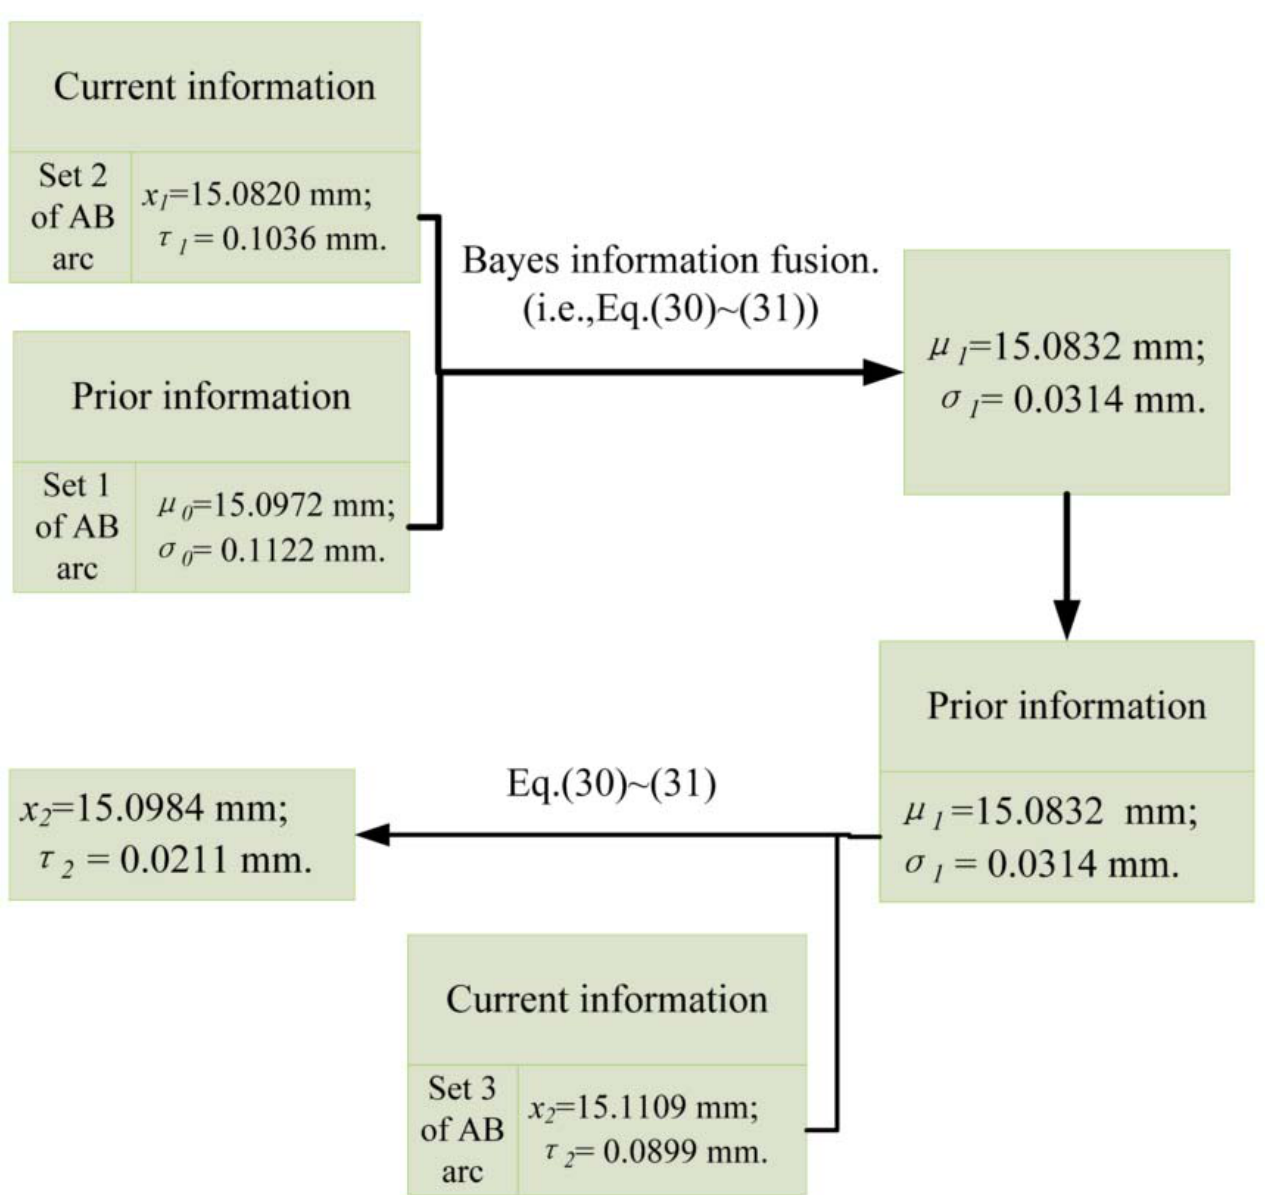
Figure 17. Type-A standard uncertainty calculation procedure based on Bayes information fusion.